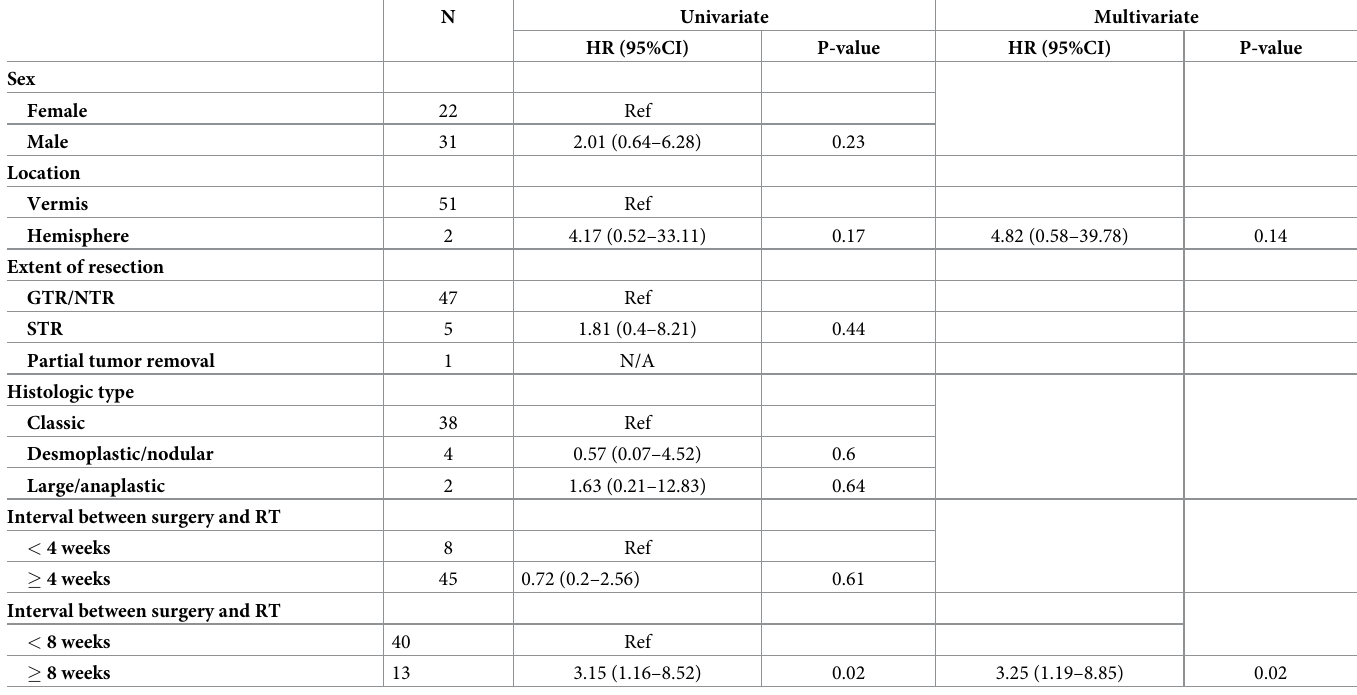
Table 2. The association analysis of various factors and the overall survival of the medulloblastoma pediatric patients.